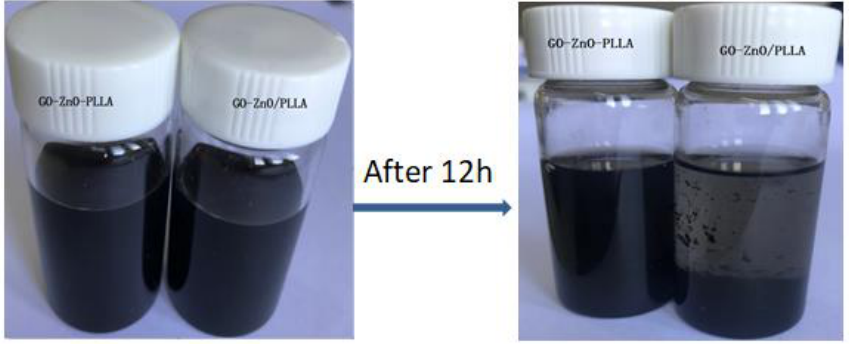
Figure 9. Dispersions of GO-ZnO-PLLA and GO-ZnO/PLLA in chloroform.